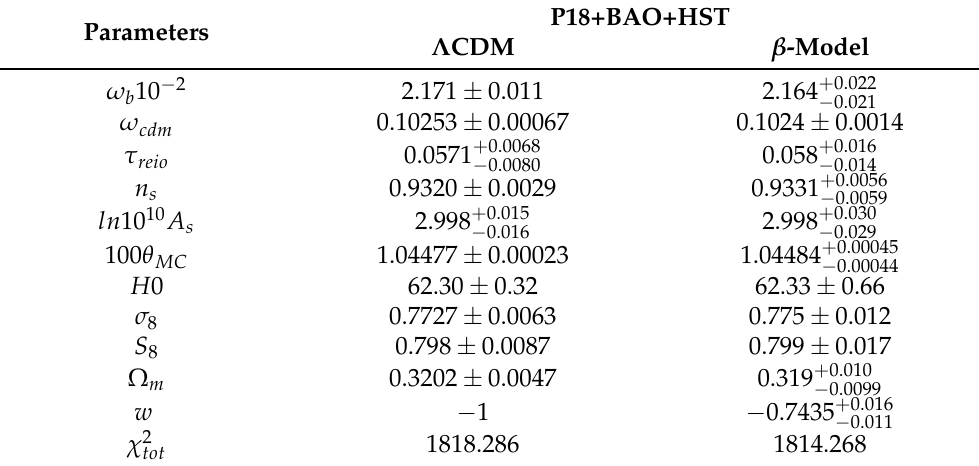
denotes the total mean χ 2 of the combined joint tot